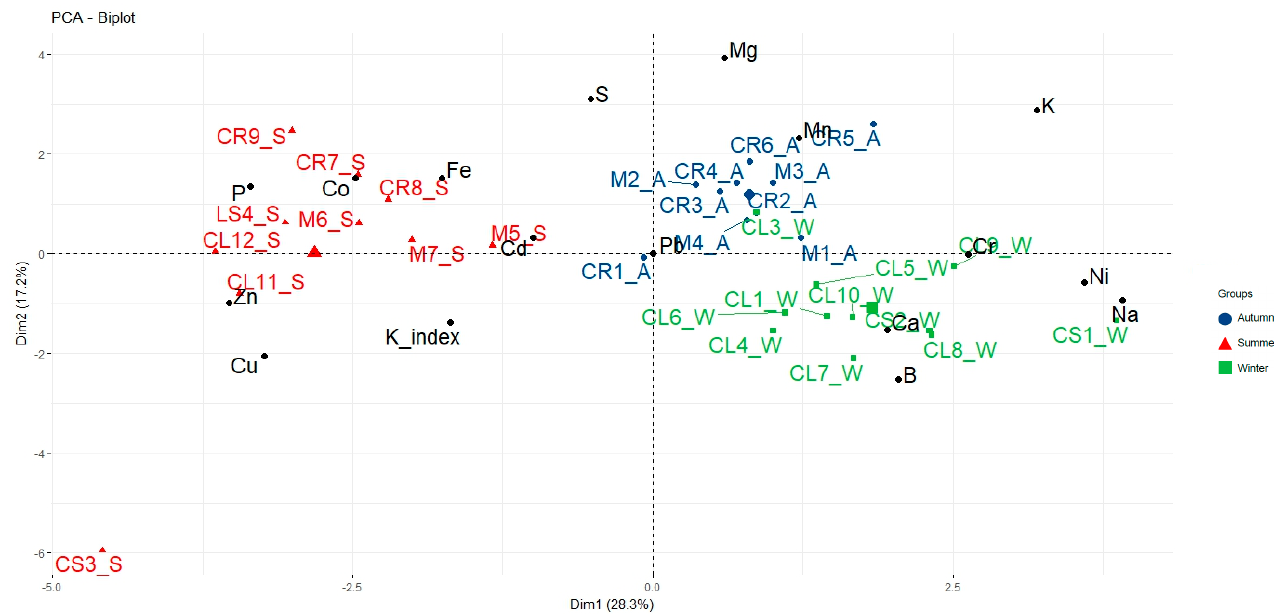
Figure 5. Principal component analysis of each fish species Chelon ramada (CR), Chelon labrosus (CL), Chelon saliens (CS), Mugil cephalus (MC) metal contents and Fulton’s condition index (K index) along the seasons Autumn II (A), Winter III (W), Summer V (S).